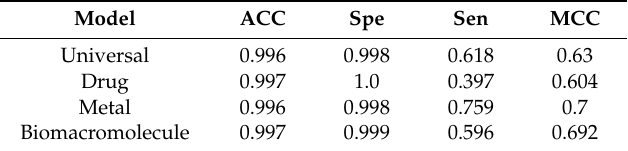
Table 4. Performance of MPLs-Pred on the independent testing dataset with the universal model and ligand-specific